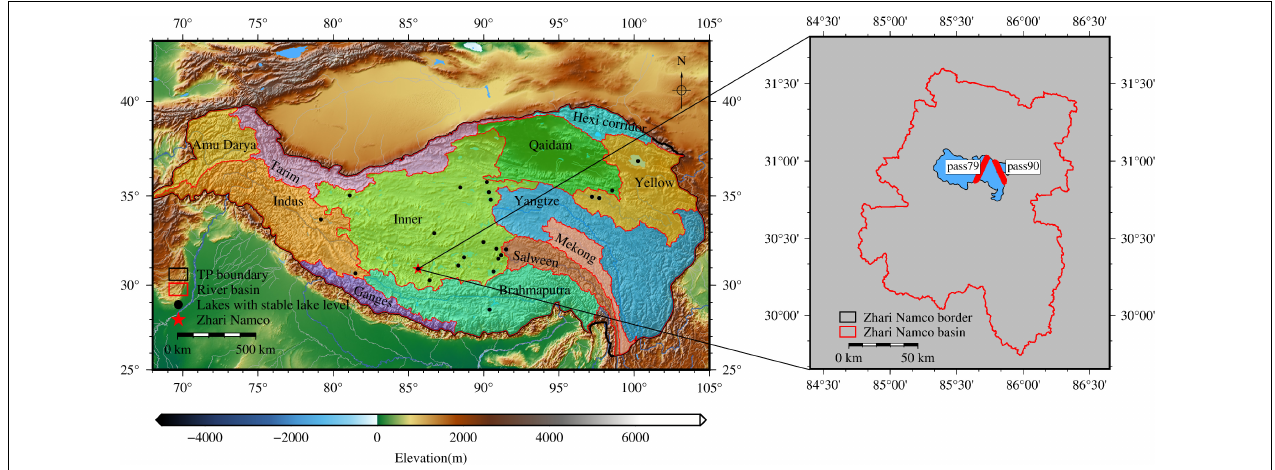
FIGURE 1 | Study area and satellite ground tracks trough Zhari Namco.